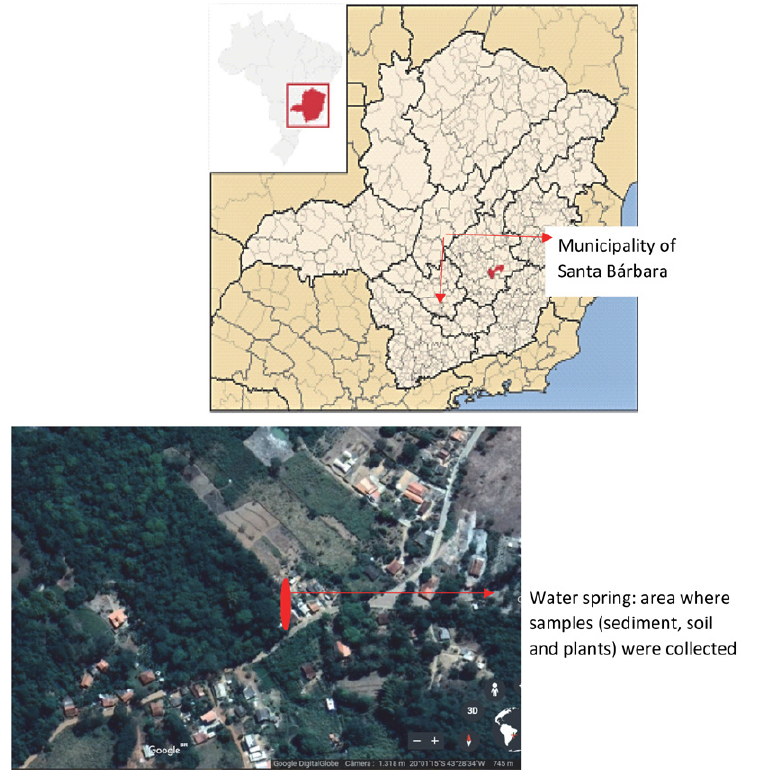
Figure 1. Sampling locations in Santana do Morro (Santa Bárbara district, Minas Gerais, Brazil) (https://earth.google.com/web/@-20.02021163,